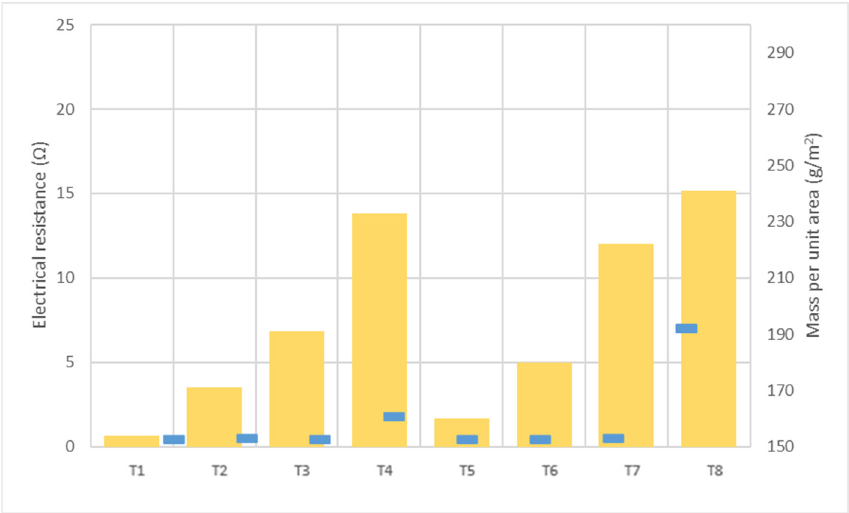
Figure 3. Graphic representation of the relation between electrical resistance of the printings meas- ured on warp direction ( ) and the mass per unit area ( ). Figure 2. Graphic representation of the electrical resistance of the printings ( ) measured on warp direction and ( ) meas- ured on weft direction. ( a ) Electrical resistance affected by the structural variations of the textiles; and ( b ) Electrical re-